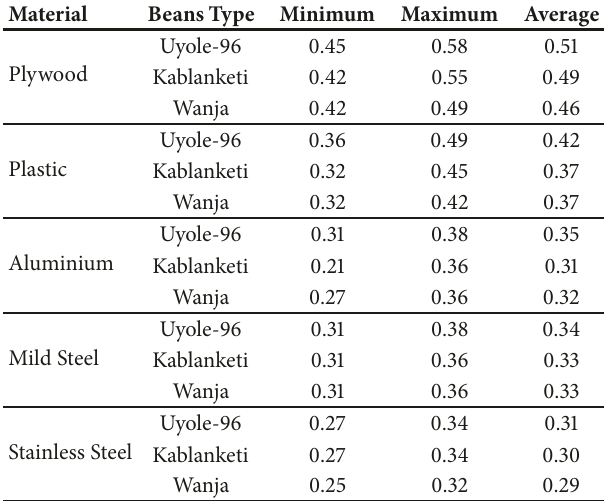
Table 5: Coefficients of friction on dissimilar sliding material surfaces (one seed at a